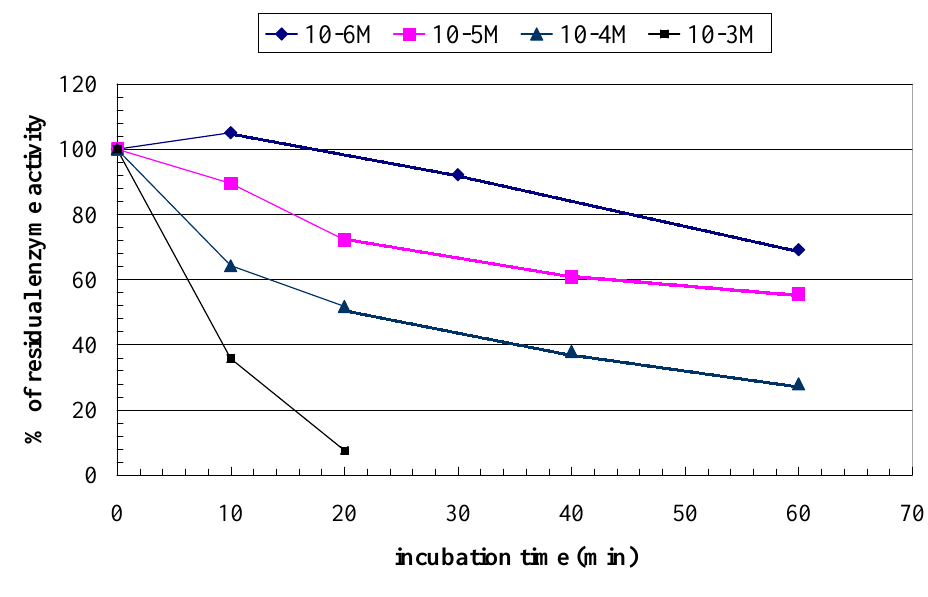
Figure 2. Inhibition effect on the BuChE-BSA FET sensor by trichlorfon. Percent of residual enzyme activity as a function of incubation time.